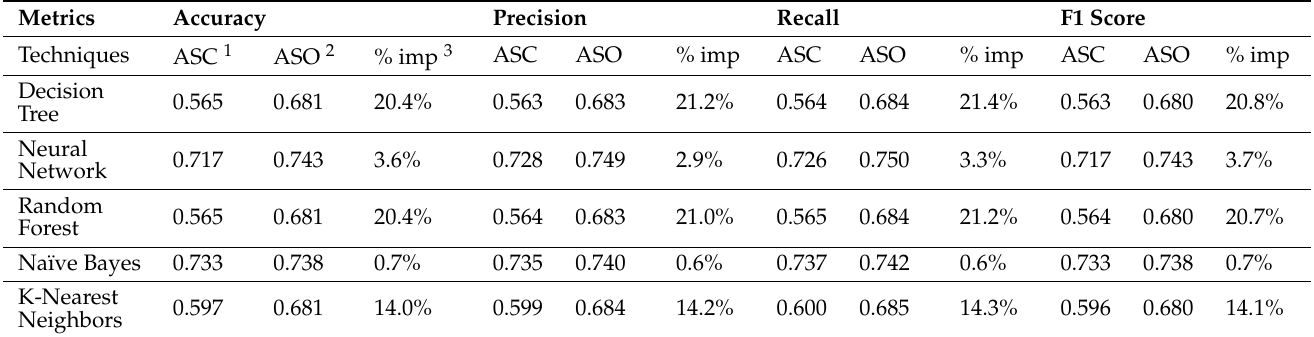
Figure 3. Model comparison for different techniques based on optimized admission scores (ASO). Table 3. Evaluation metrics for all models using current and optimized admission scores.